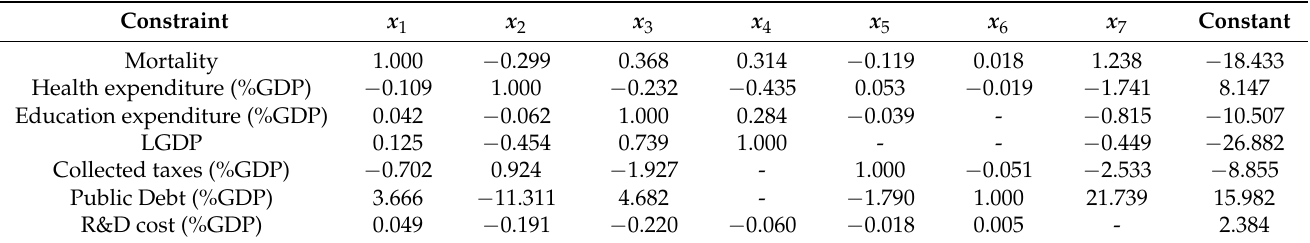
Table 4. Estimated parameters for the constraint of the multiobjective